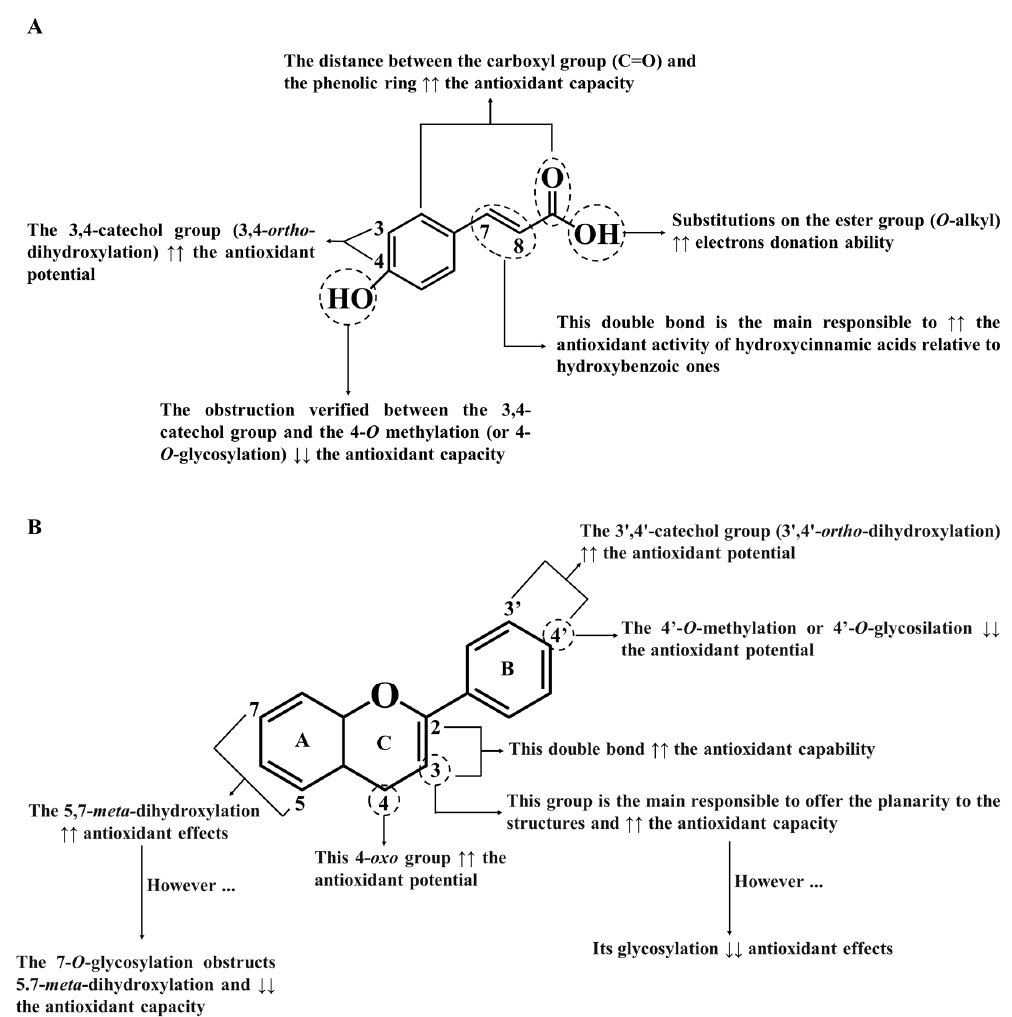
Figure 3. The main structure-activity relationship is responsible to influence the antioxidant capacity of phenolic acids ( A ) and flavonoids ( B ) (adapted from Bento et al. [34]). All of these findings explain the lower antioxidant activity of kaempferol compared to luteolin; although both have the same hydroxyl configuration, kaempferol does not have the catechol group on the B ring, and, therefore, is less effective [73]. Moreover, the presence of a free hydroxyl group at position 3 in flavan-3-ols and flavonols is an added value because it can originate intramolecular hydrogen bonds with the 3 ′ ,4 ′ -catechol structure of the B ring, aligning it towards the A ring [74]. This torsion angle on the B ring concerning the rest of the molecule contributes to the planarity of the structure, promotes conjugation and electron dislocations, and thus reduces radical species amounts [73]. A good example of this evidence is quercetin, which effectively presents remarkable chelating and scavenging potential, while flavones and flavanones are less effective in reducing oxidative stress because they do not possess a 3-hydroxyl group in their structure [75]. On the other hand, conjugation with carbohydrate and glycoside residues on A and/or B rings decreases the antioxidant activities of flavonoids [68]. This explains why quercetin aglycone has a stronger scavenging potential towards peroxyl radicals and ferric species than its O- glycosylated derivatives [71,76]. Among the sugar substitutions, the glycosylation at position 4 ′ is more suppressive than the substitutions at positions 3 and 7 of the C- and A-rings, respectively, whereas the substitution at position 3 elicits a